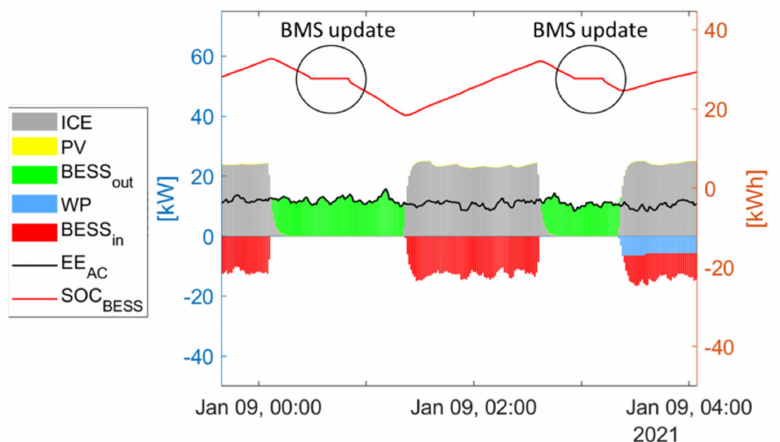
Figure 5. Example of state of charge (SOC) measure during experimental operations: the SOC update by the battery management system is highlighted in the circled